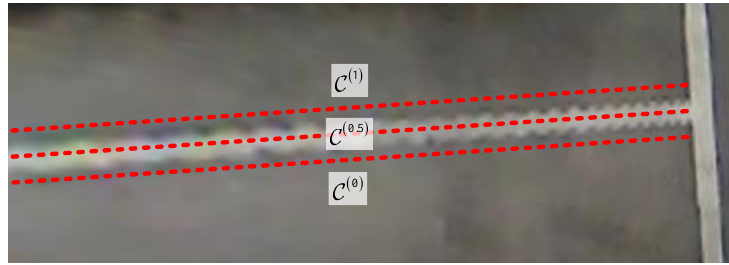
Figure 7. Method to determine the candidate line edge by average pixel gray value.